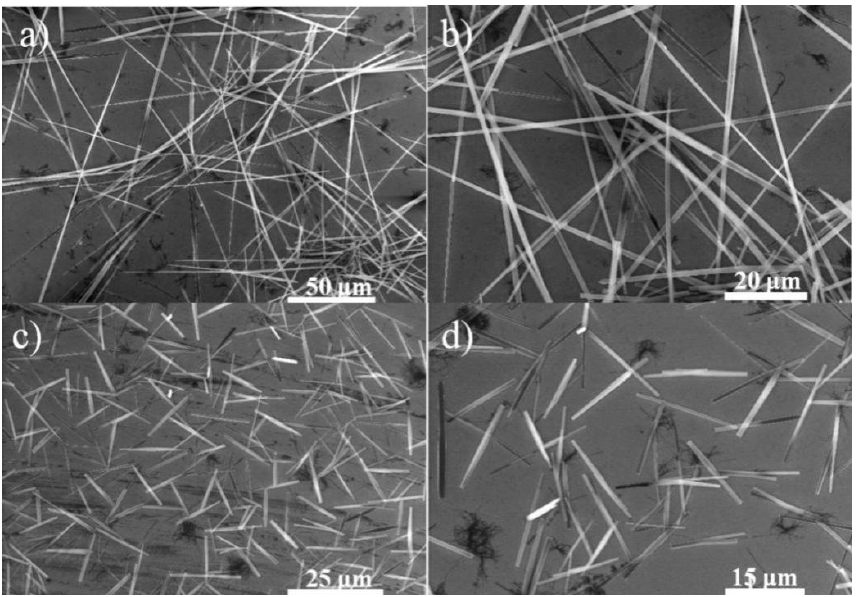
Figure 1. The self-assembled wire-like ( a , b ) and rod-like ( c , d ) aggregation structures of